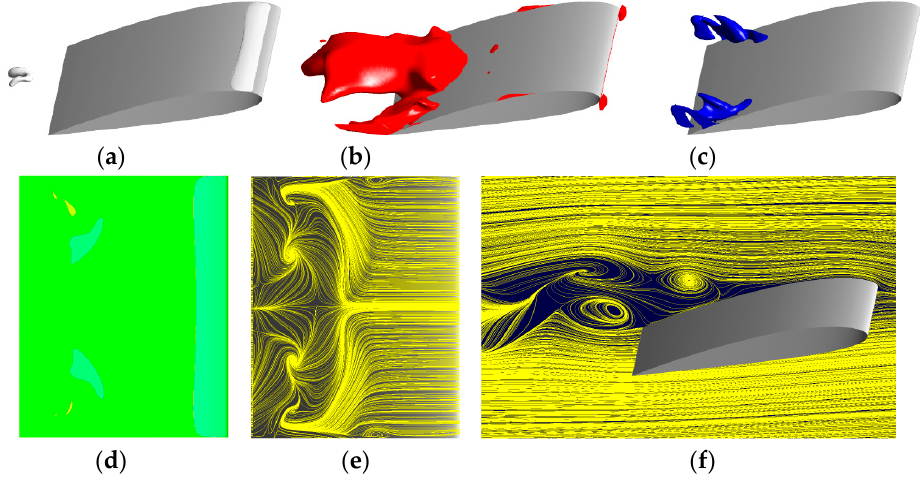
Figure 25. Time instant 5. ( a ) 3D view of cavitation regions (in white); ( b ) back-flow regions (in red); ( c ) evaporation regions (in light cyan) and condensation regions (in dark blue); ( d ) temperature differences on hydrofoil suction side; ( e ) vector lines on hydrofoil suction side; ( f ) vector lines in symmetry plane.